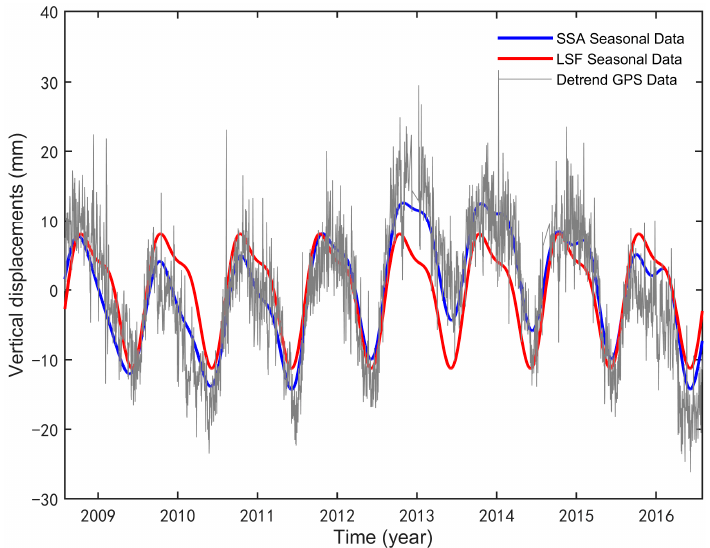
Figure 9. Comparison of the seasonal signals (annual + semiannual) extracted by the SSA and LSF methods at KAGA station.